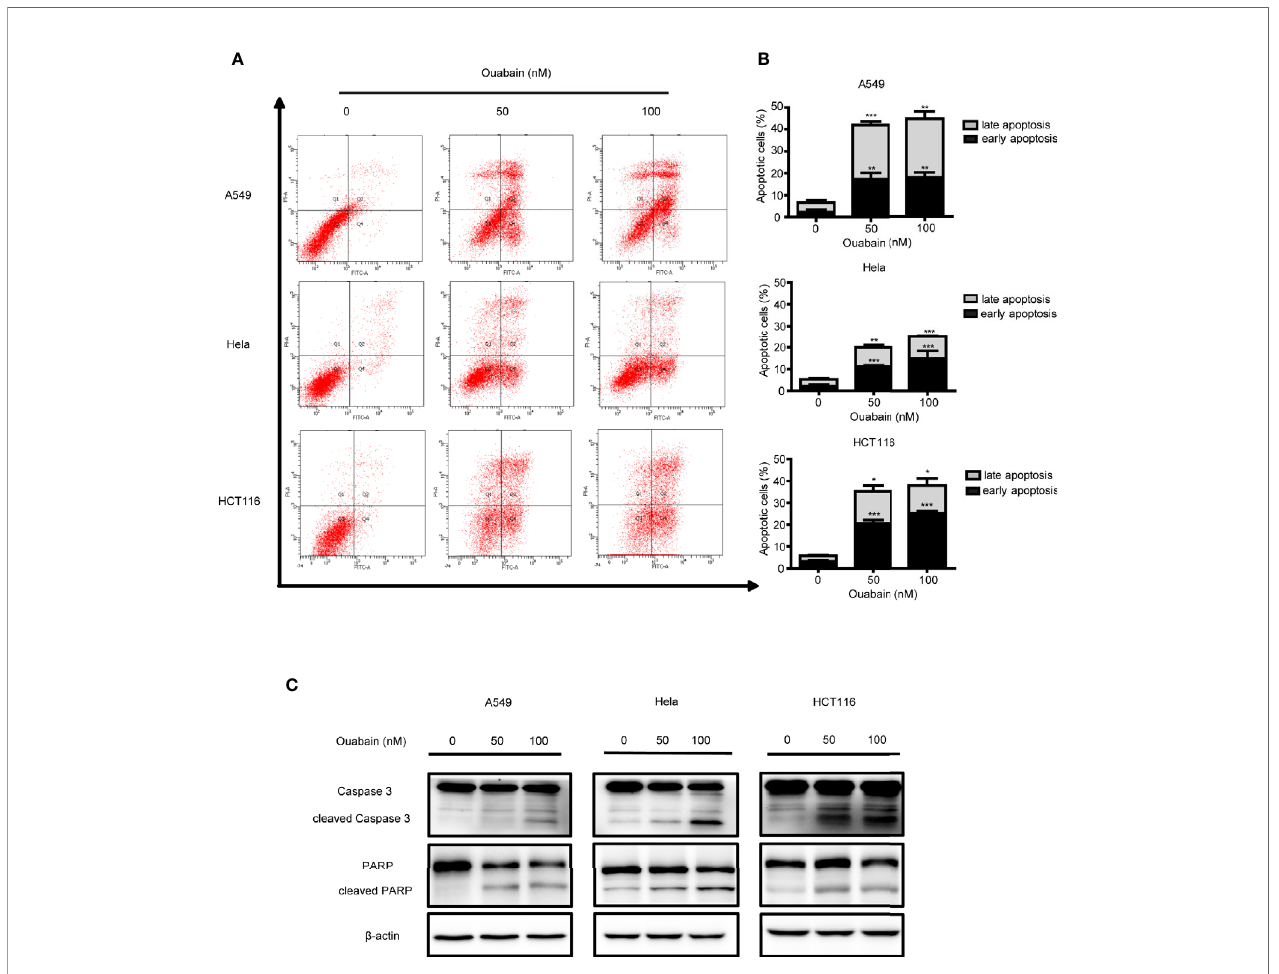
FIGURE 2 | Ouabain induced apoptosis of cancer cells. (A, B) A549, Hela and HCT116 cells were treated with indicated dose of ouabain (0, 50, 100 nM) for 48 hours, apoptosis was tested by fl ow cytometric analysis with Annexin V-FITC/PI staining. (C) The expressions of PARP, cl-PARP, Caspase3, cl-Caspase3 were analyzed by Western blotting. b -actin was used as a loading control. * P < 0.05; ** P < 0.01; *** P < 0.001 versus control group, n =